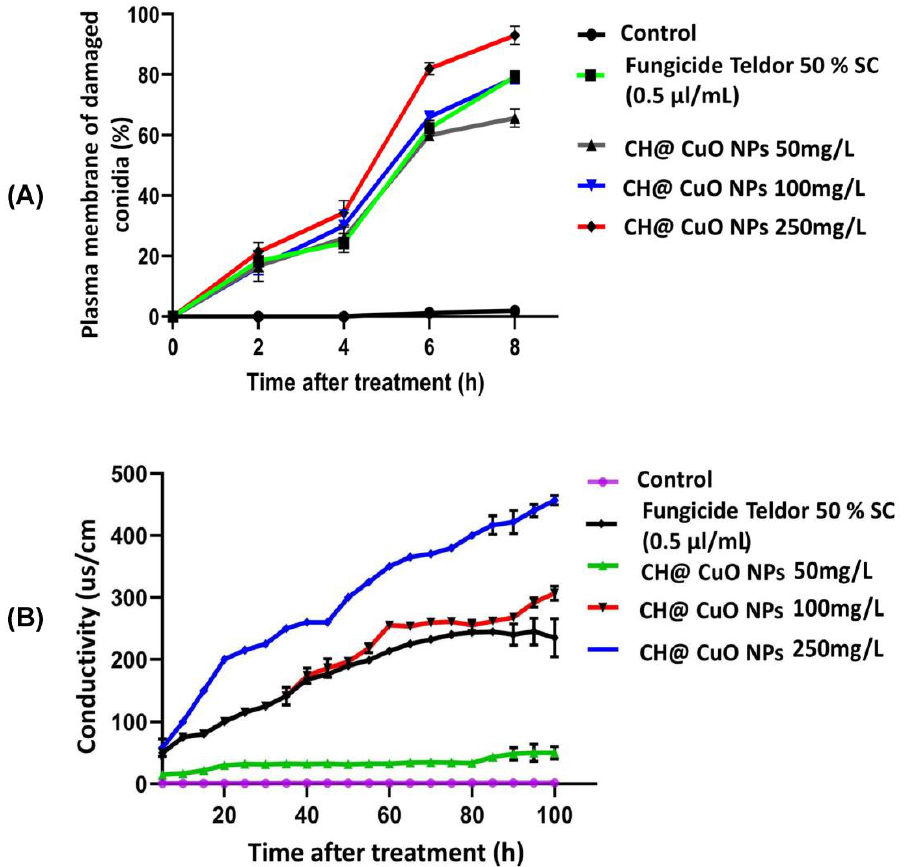
Figure 4. ( A ) The percentage of plasma membrane damaged conidia after treatment with CH@CuO NPs at different concentrations 50, 100 and 250 mg/L in comparison to Teldor 50% SC. ( B ) Electrolyte leakage from B. cinerea suspension during different time exposure to different concentrations of CH@CuO NPs compared to the fungicide.